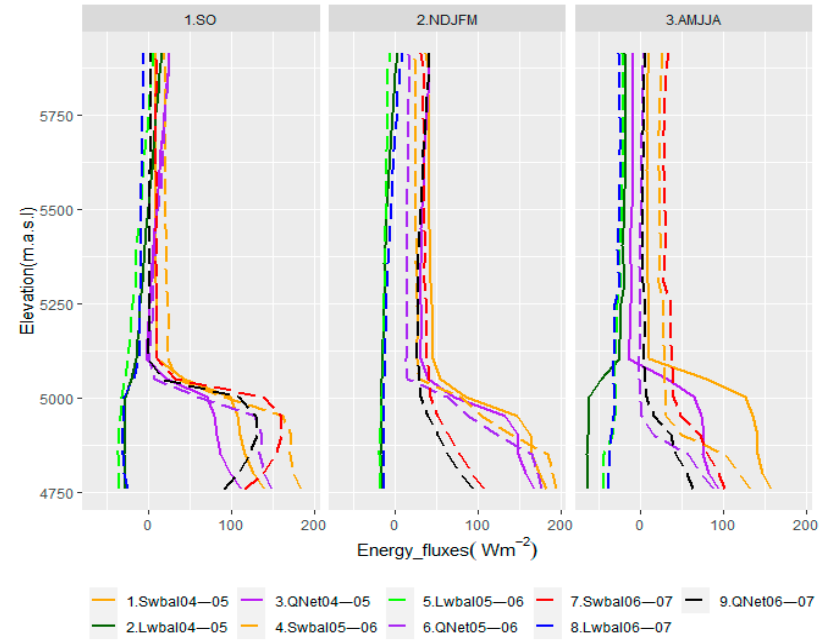
Figure 10. Similar to Figure 9, but for shortwave, longwave, and net radiation fluxes.